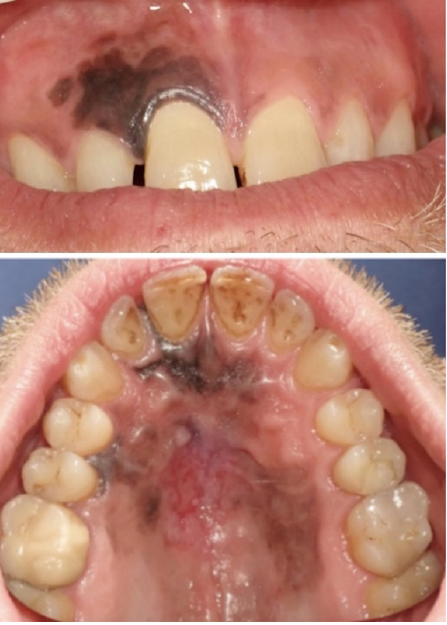
Figure 1. Clinical pictures of the oral pigmented lesions at the first oral pathology visit. Upper gingiva and palatal view.